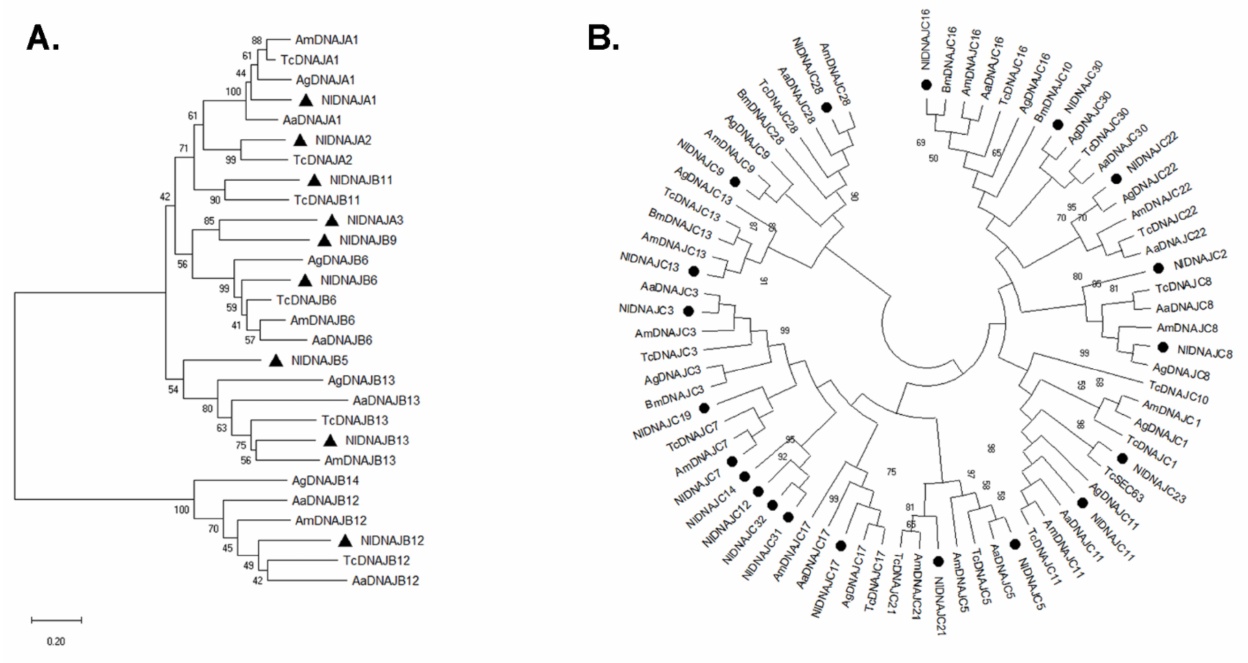
Figure 3. Phylogenetic analysis of DNAJ genes in BPH. ( A ) The phylogenetic tree constructed based on 25 DNAJA and DNAJB homologs derived from four species (Table S1). ( B ) The phylogenetic tree constructed based on 51 DNAJC homologs derived from five species (Table S1). The phylogenetic trees were constructed by the neighbor-joining method and bootstraps were set with 1000 replications. NlDNAJ members are shown with black